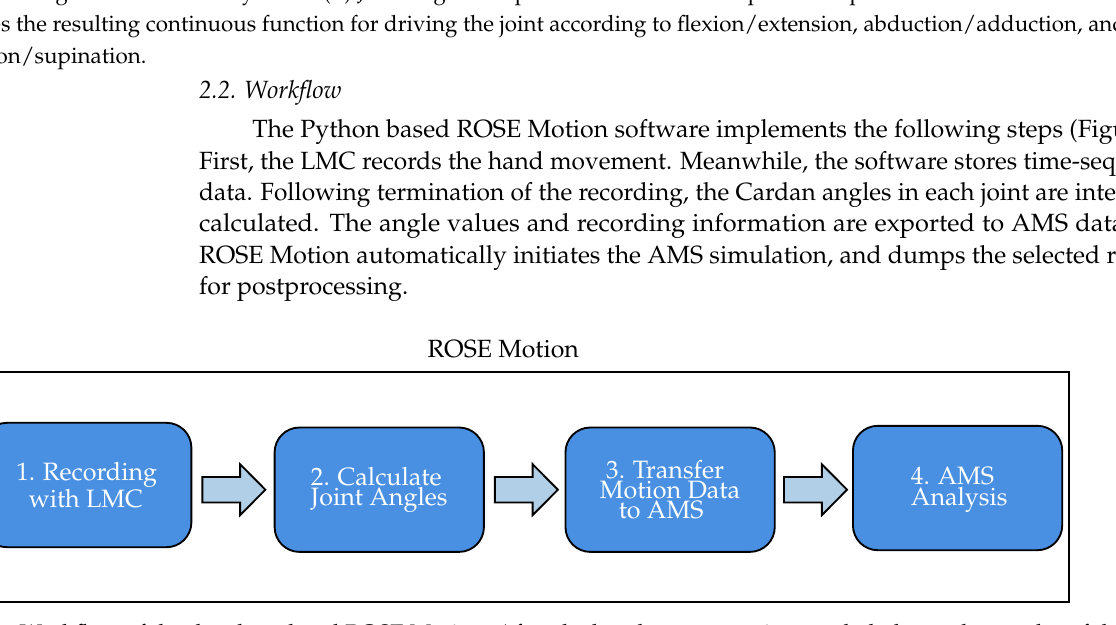
Figure 2. Workflow of the developed tool ROSE Motion. After the hand movement is recorded, the cardan angles of the various finger joints are calculated for each frame. The calculated time-sequence data is transferred via data files to the AMS. The simulation starts